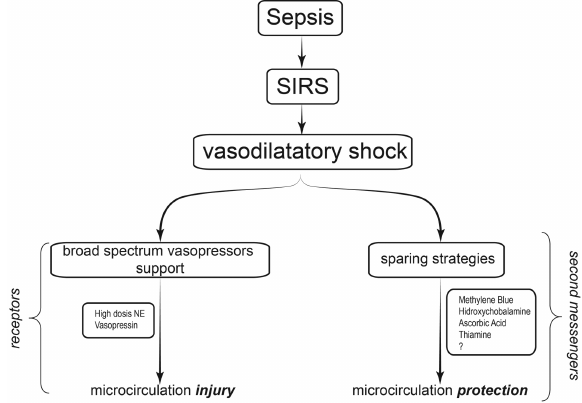
Figure 2. Schematic presentation showing that “sparing strategies” and “microcirculatory protection” have pivotal role to avoid the “broad spectrum vasopressors